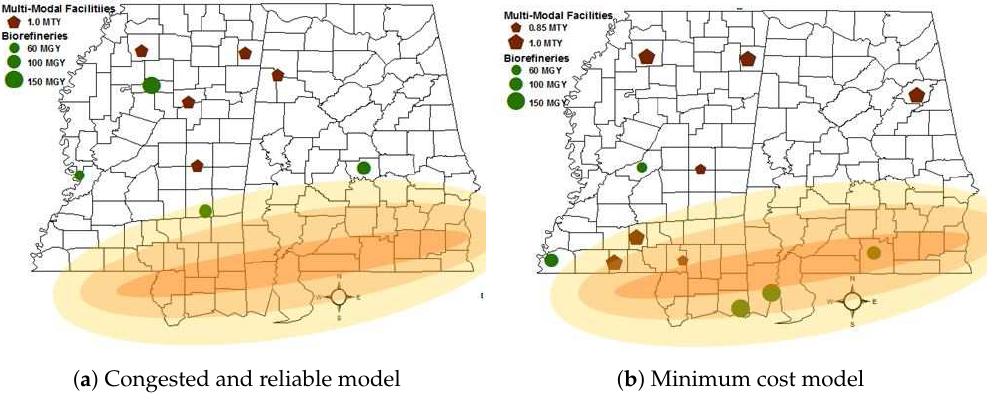
Figure 8. Network representation of different disruption scenarios on system